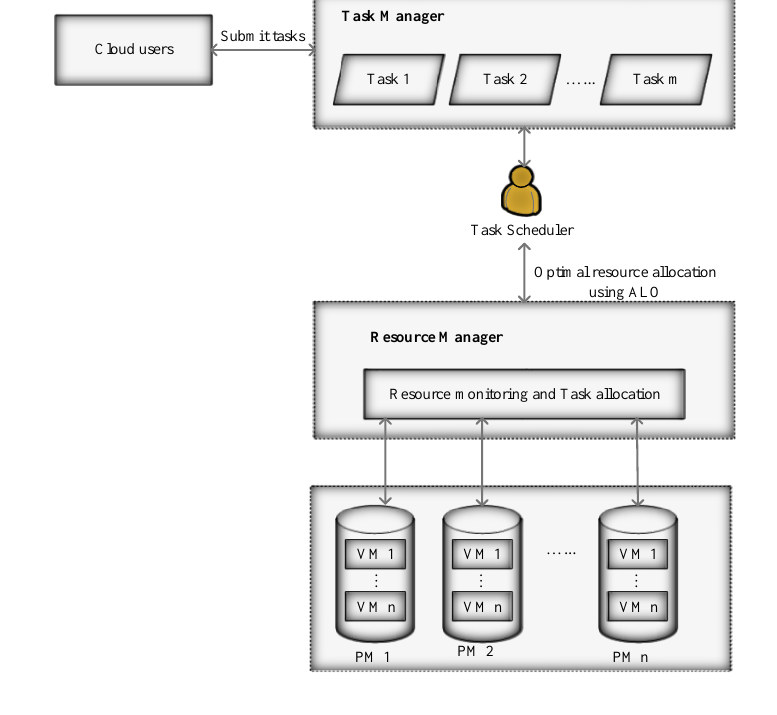
Figure 3. Proposed antlion based optimization model